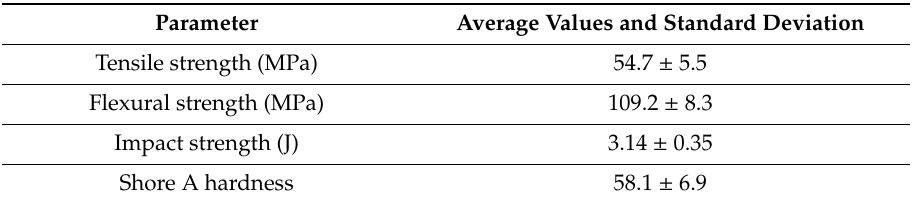
Table 9. Confirmation experiment results.